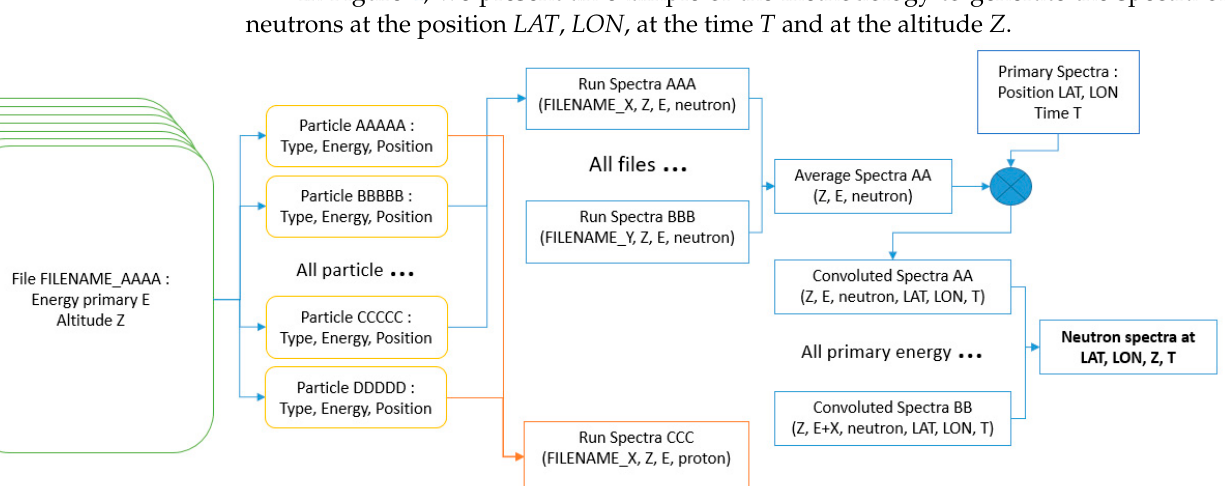
( b ) Figure 5. Evolution of the atmospheric composition and density based on MSISE2000 for Paris, France on 21 June 2022: ( a ) Evolution of the atmosphere density as a function of altitude; ( b ) Evolu- tion of the constitution of the atmosphere as a function of altitude.